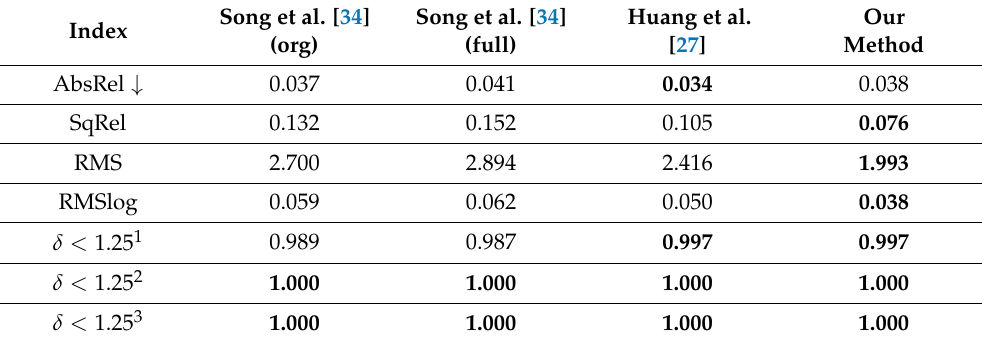
Table 4. Quantitative results of distance estimation for the Tusimple